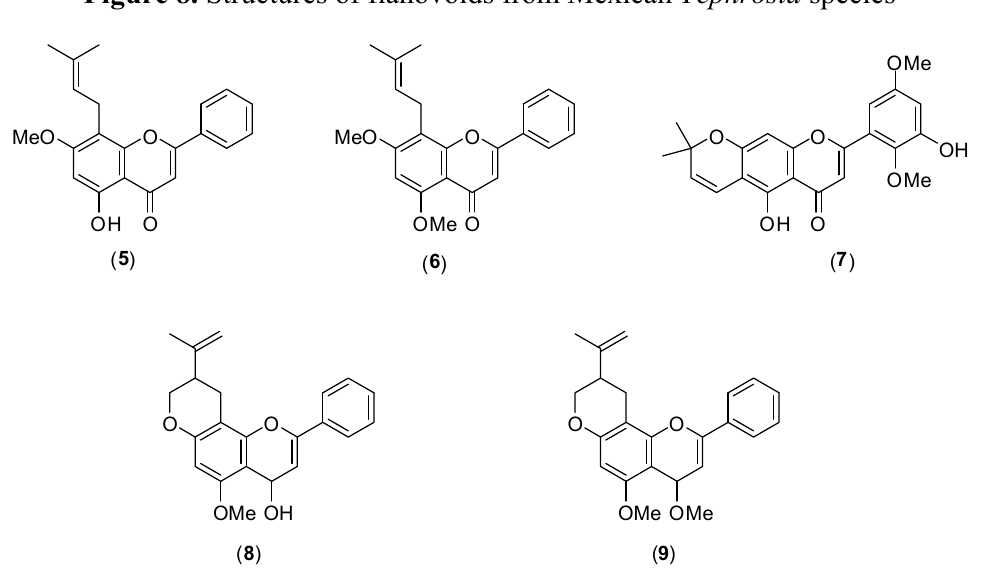
Figure 8. Structures of flanovoids from Mexican Tephrosia